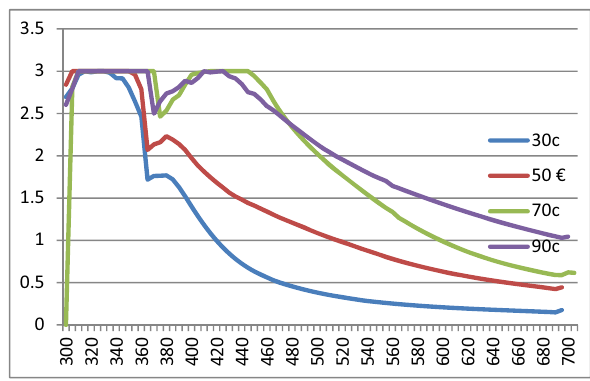
Figure 3: Temperature e ff ect of methanolic nanoparticles of Tropaeolum majus .